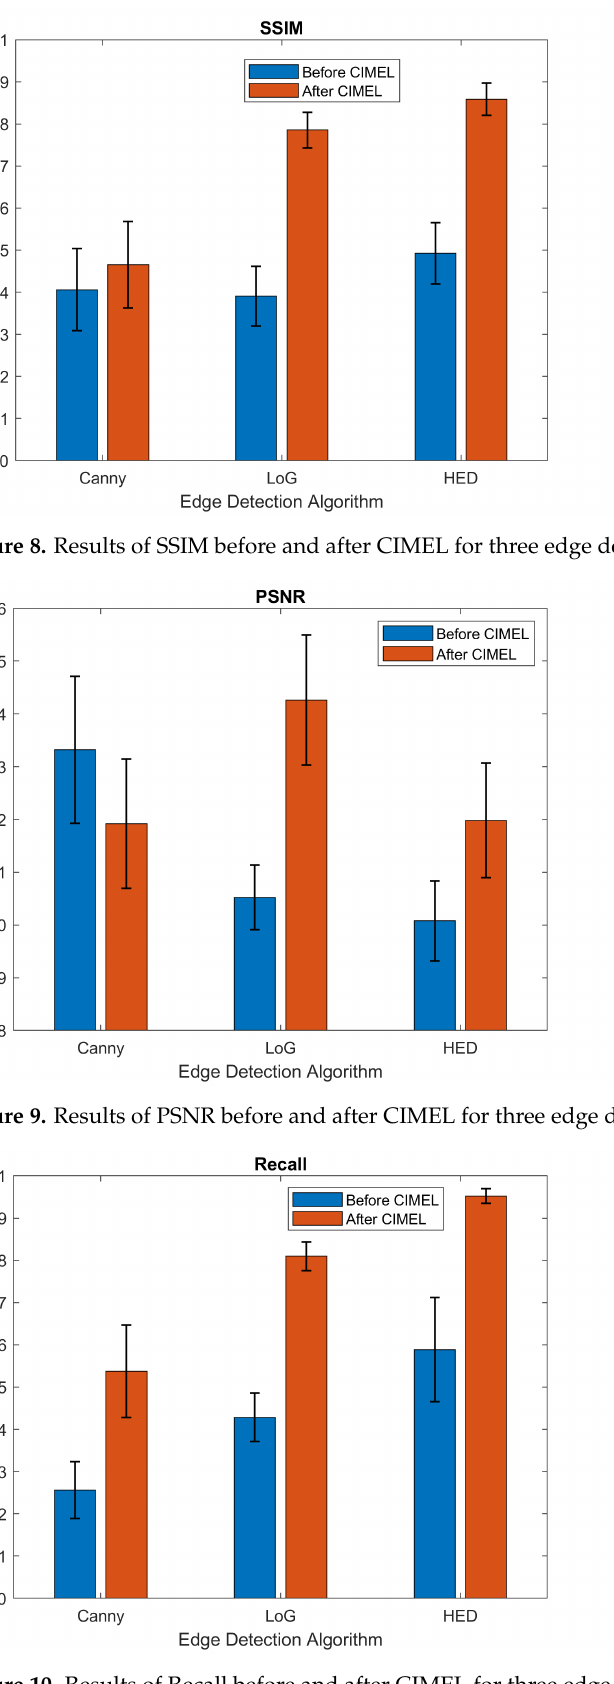
Figure 10. Results of Recall before and after CIMEL for three edge detection